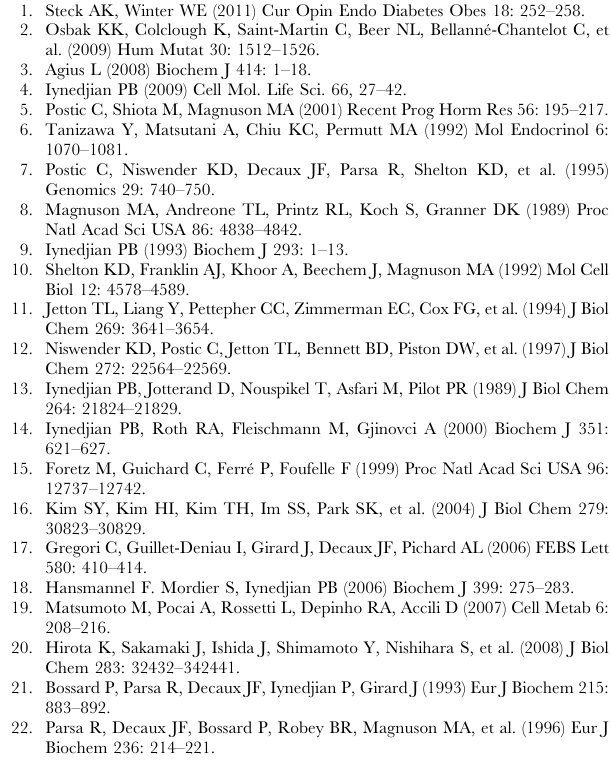
and sequence shown high GC content are also identified using the symbols shown in box at the lower right. Figure S3 Characterization of the human L-02 normal liver cell line. Expression of genes involved in glucose metabolism in HepG2 and L-02 cell lines was assed by RT-PCR (primers listed in Table S2). Cells were tested under basal conditions or after stimulation by 100 mM insulin or 10% fetal calf serum for 20 hours. Beta-actin and GAPDH were used as controls. Table S1 Primers used to generate human glucokinase reporter gene constructs.